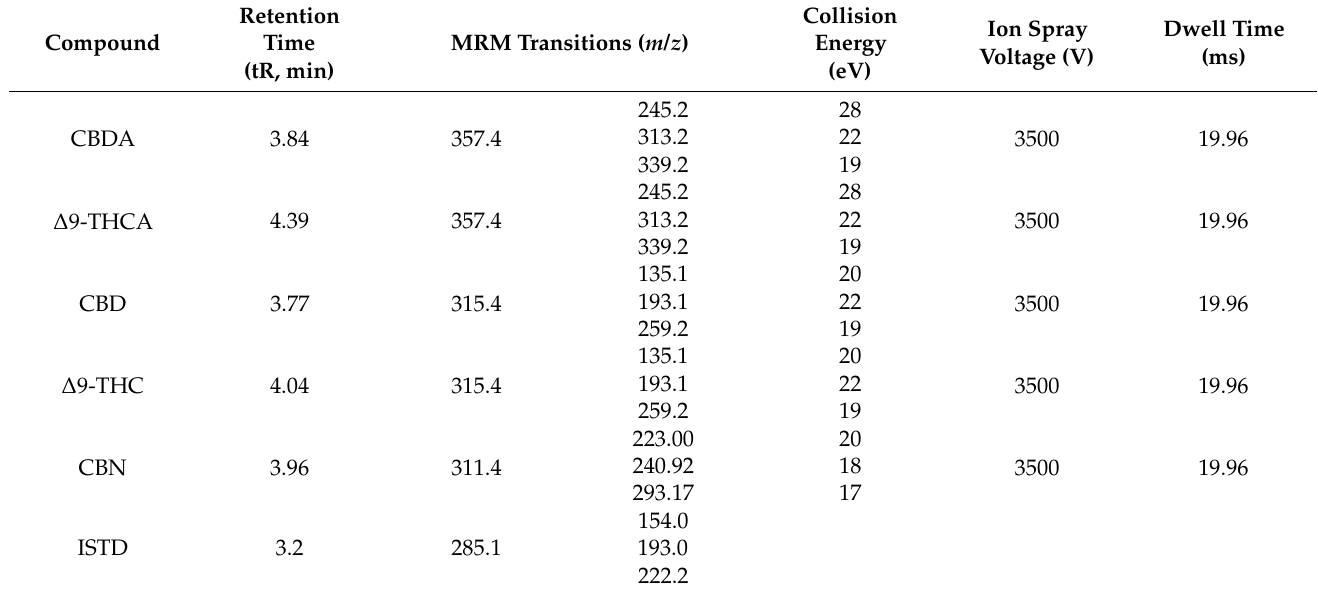
Table 5. MRM transitions of target